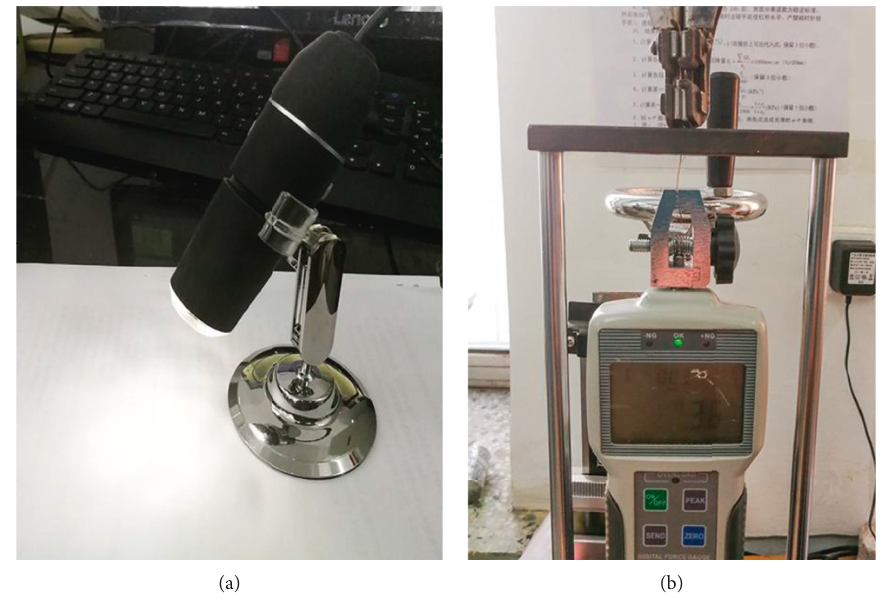
Figure 4: Operating process of the pull-out experiment. (a) Diameter measuring. (b) Stretch testing.